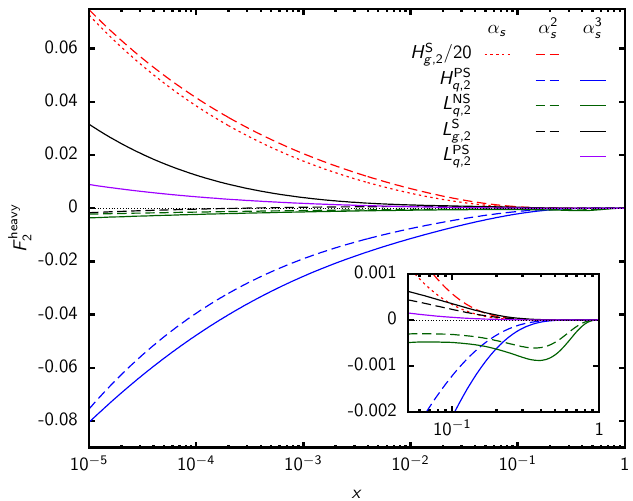
Figure 2: The different single mass heavy flavor contributions to the structure function F at Q 2 = 100GeV 2 . From [120]. 2